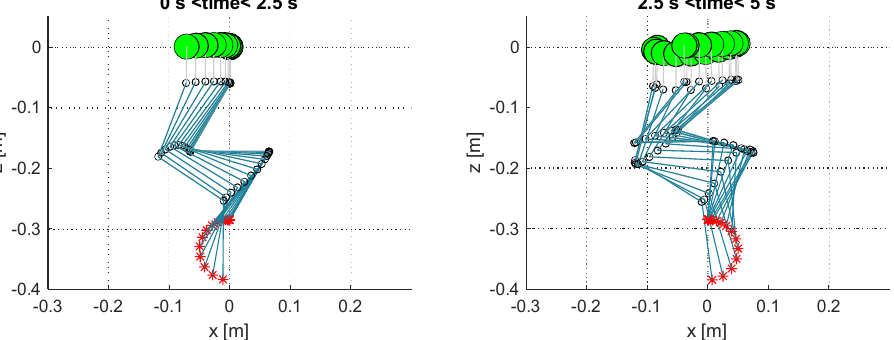
Figure 14. Stroboscopic trajectories for the first half ( left ) and second half ( right ) of the circular trajectory task for the 3-DOF redundant UAM using the generalized Jacobian with external forces. The UAV base is the large green marker, joints are the black circles, links are the blue lines, and end-effector positions tracked are the red crosses.